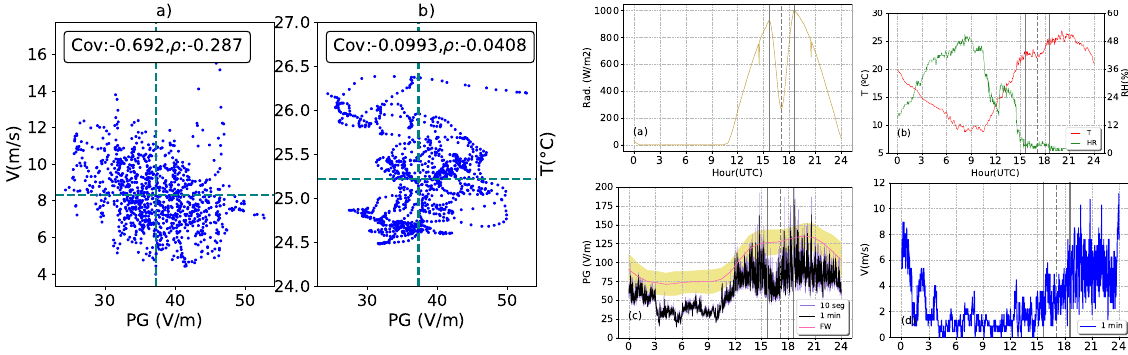
Figure 7: Measurements at CASLEO during the total solar eclipse of 14 December 2020: (a) solar irradiance every 1 minute, (b) temperature (red) and relative hu- midity (green) every 1 minute, (c) PG every 10 seconds (light violet), the 1 minute average (black) and the FW- PG daily mean curve as calculated at CASLEO (data from Tacza Jose, thank you for providing us with the FW curve data, pink line)with ± σ (standard deviation) in yellow shading, and (d) wind speed every 1 minute (blue). The vertical grey lines indicate the start, maxi- mum (dashed) and end times of the eclipse for the